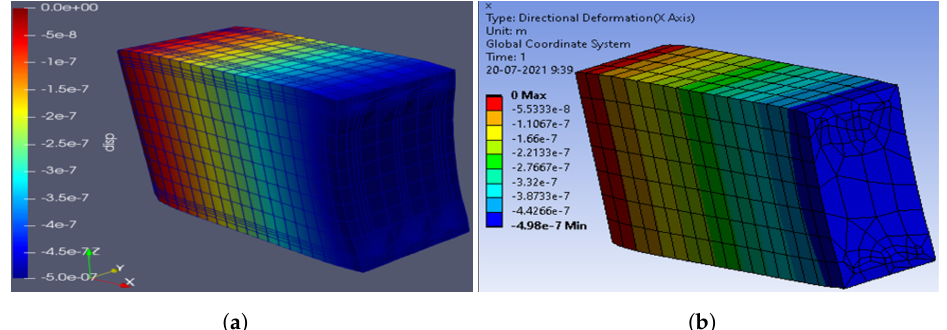
Figure 7. One side fixed beam, submitted to a compression force (1000 N). ( a ) Paraview (Python), ( b ) ANSYS.